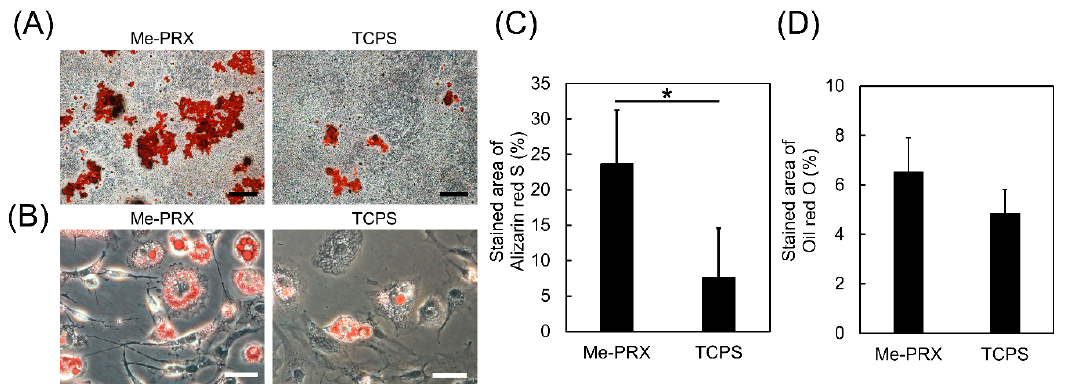
Figure 6. ( A ) Alizarin red S staining images of MC3T3-E1 cells on Me-PRX and TCPS surfaces after a